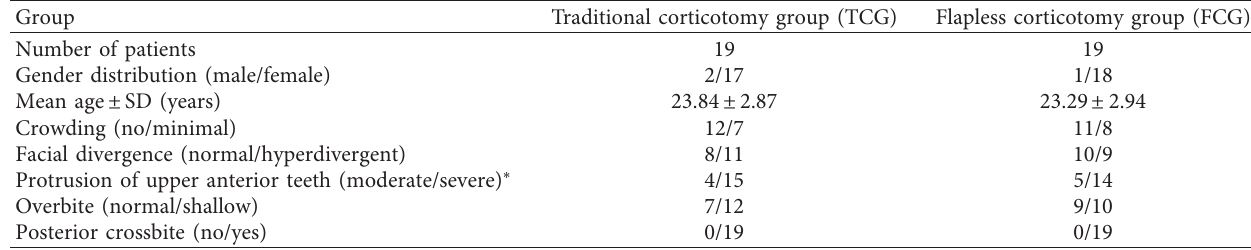
Table 1: Basic characteristics of the sample at the beginning of the